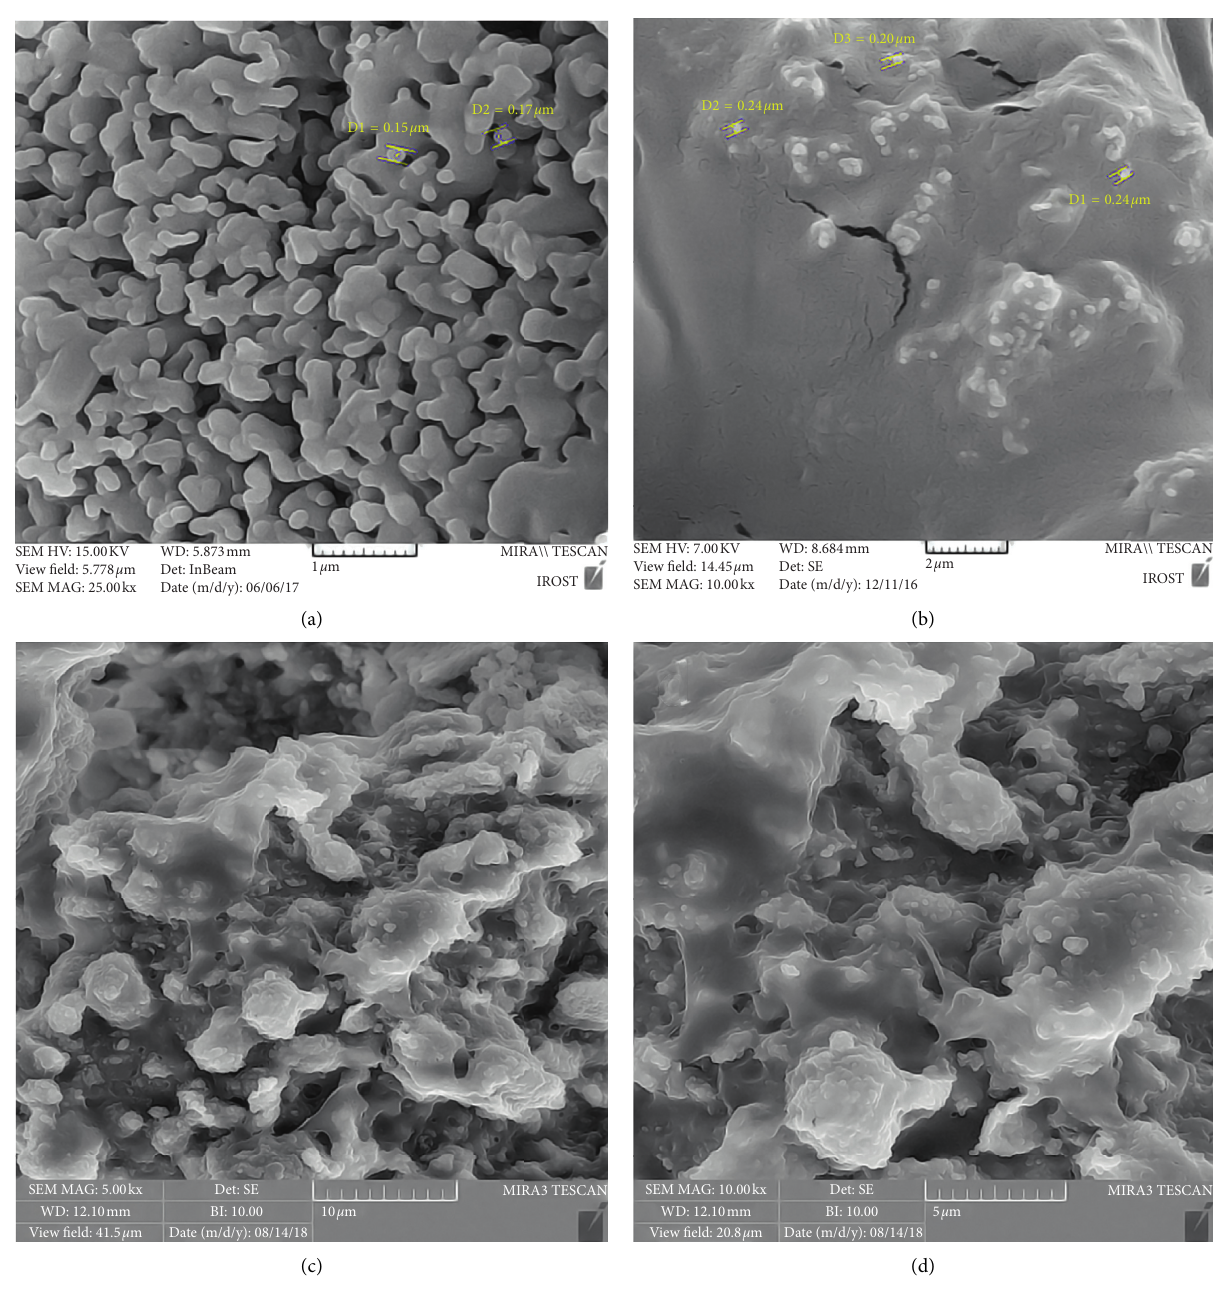
Figure 2: Scanning electron microscope micrographs of ceramic microparticles (a) before being coated, (b) after being coated with PLGA, and (c), and (d) loaded with the new combination of antibiotics–with magnification of 5x and